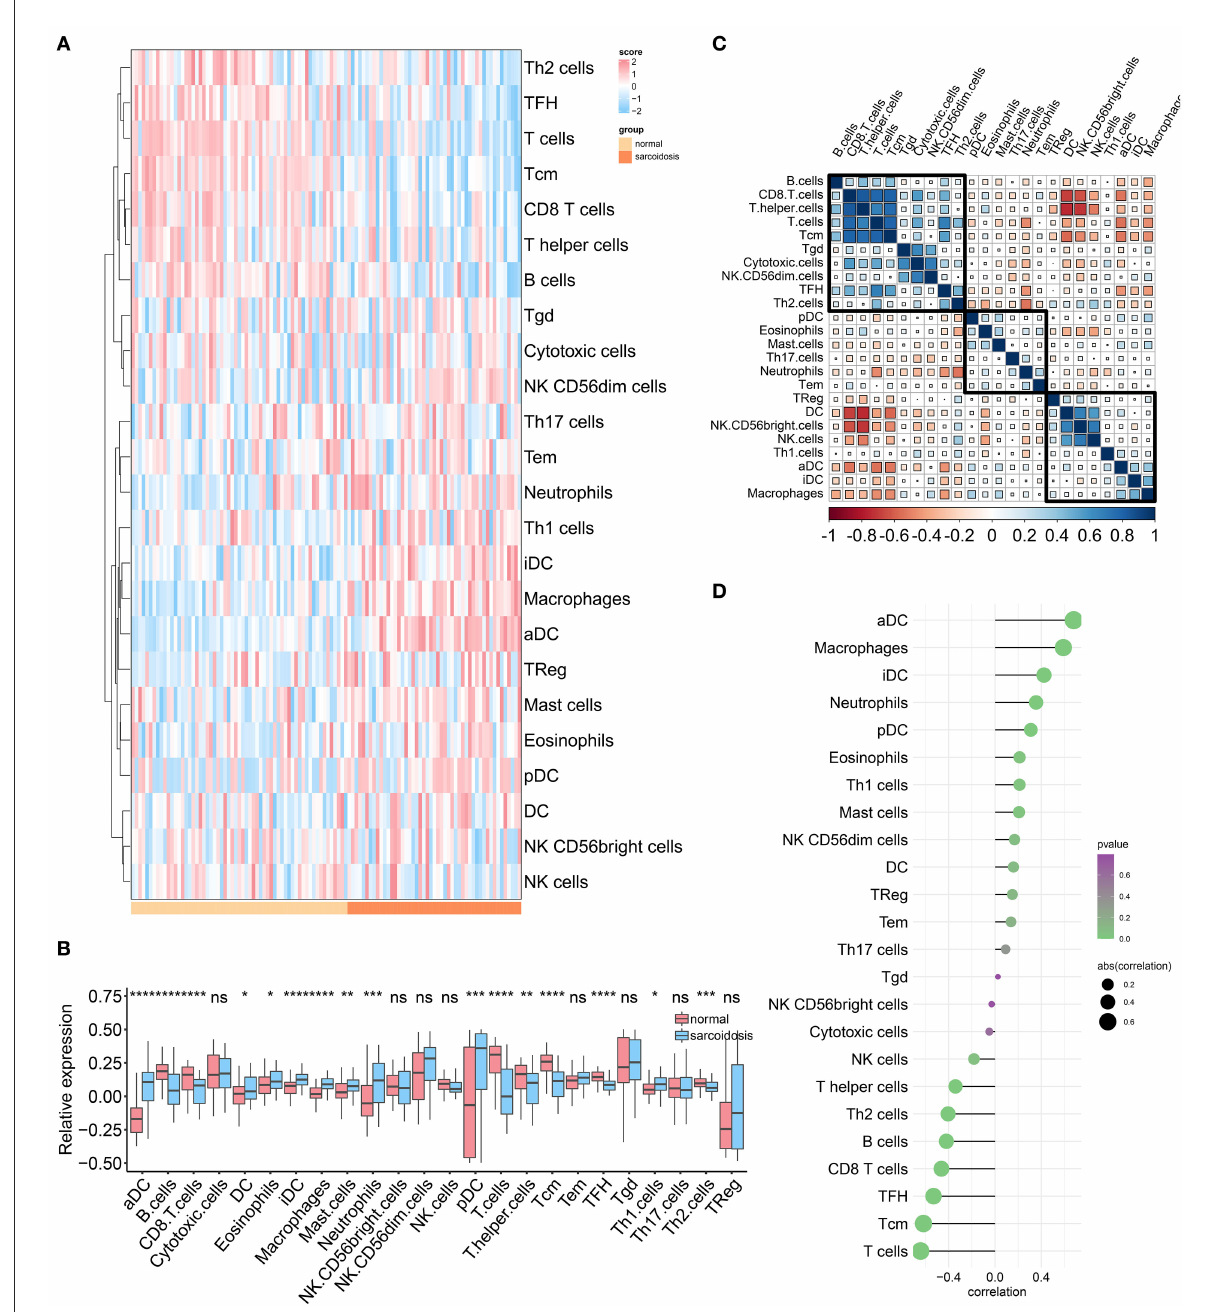
FIGURE8 The immune landscape of sarcoidosis. (A) The heatmap of the immune infiltration in sarcoidosis and normal groups. (B) The boxplot of the 24 types of immune cell infiltration in sarcoidosis and normal groups. * P < 0.05, ** P < 0.01, *** P < 0.001. (C) The heatmap of the correlations between different immune cells. (D) The relationship between the SARDS score and immune infiltration.